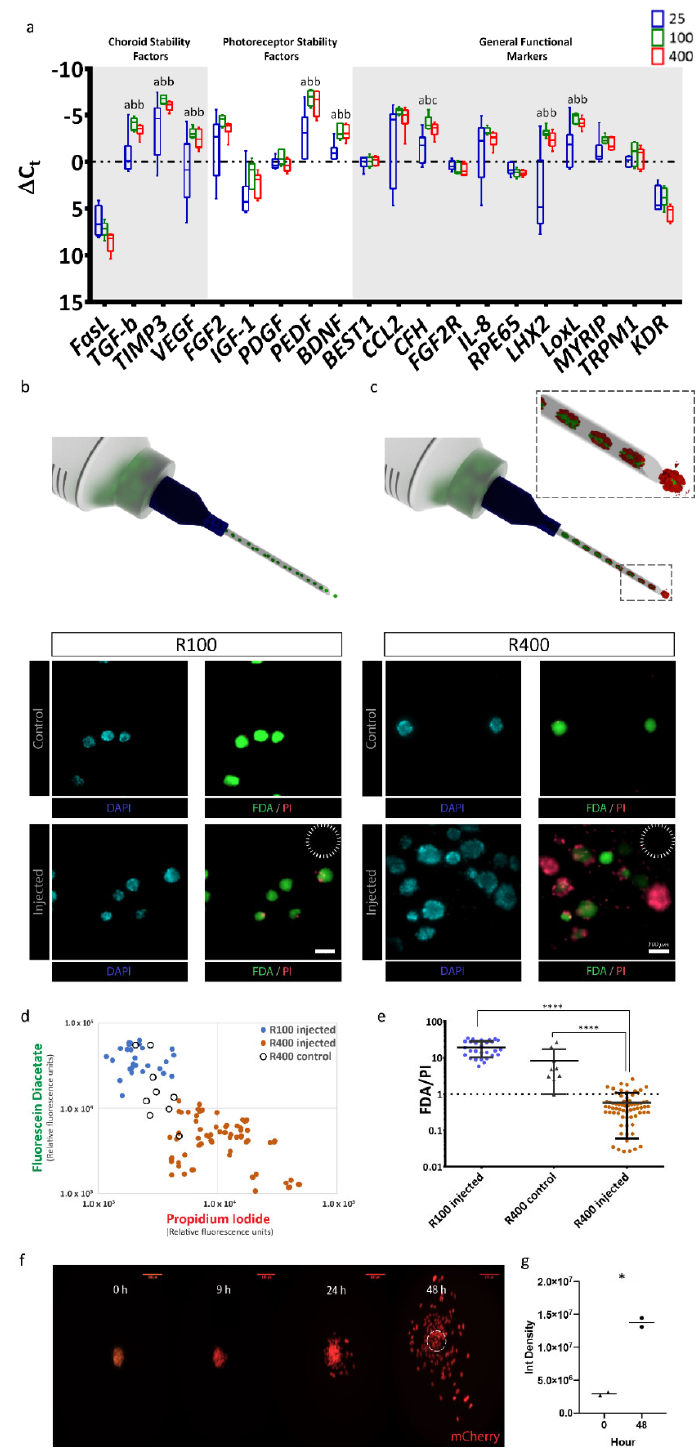
Figure 2. R100 RPE- µ Ts exhibit the desired gene-expression profile and tolerance for delivery through a 30-gauge needle. ( a ) RT-qPCR was conducted to compare the mRNA expression profiles of R25, R100 and R400 RPE- µ Ts (n ≥ 4) for genes previously reported as photoreceptor stability factors, choroid stability factors and general functional markers. Results are presented as ∆ Ct values to facilitate direct comparisons among R25, R100 and R400 RPE- µ T sizes, shown in blue, green and red, respectively. Kruskal–Wallis ANOVA followed by Dunn’s test for multiple comparisons was conducted to compare ∆ Ct values within each gene (* p < 0.05 for groups that were statistically significant).